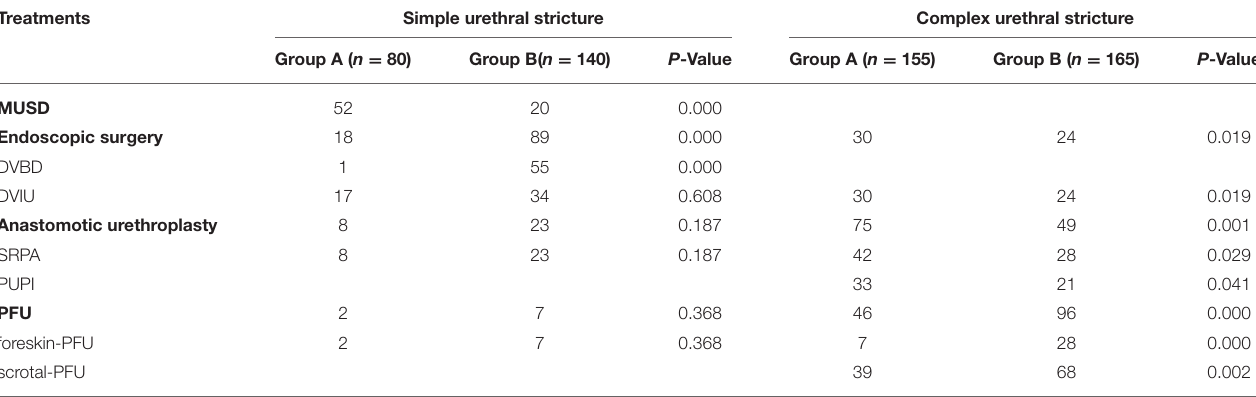
TABLE 2 | Treatment options between the two groups. Treatments